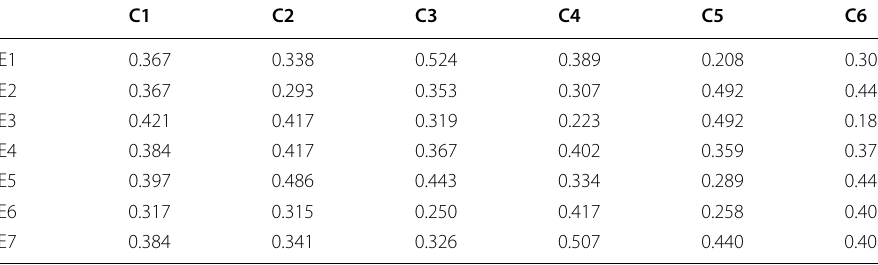
Table 21 Normalized matrix